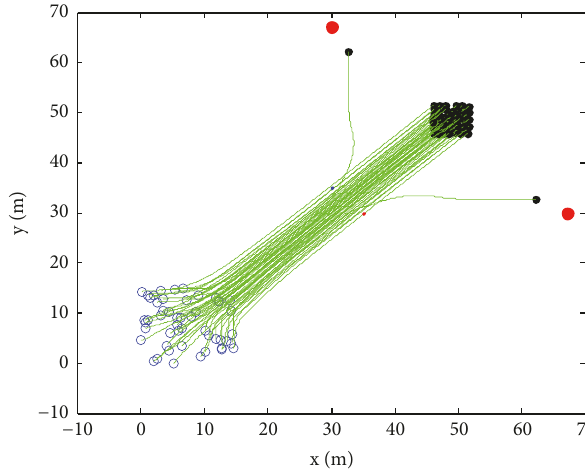
Figure 5: Trajectory of individuals under the control algorithm of